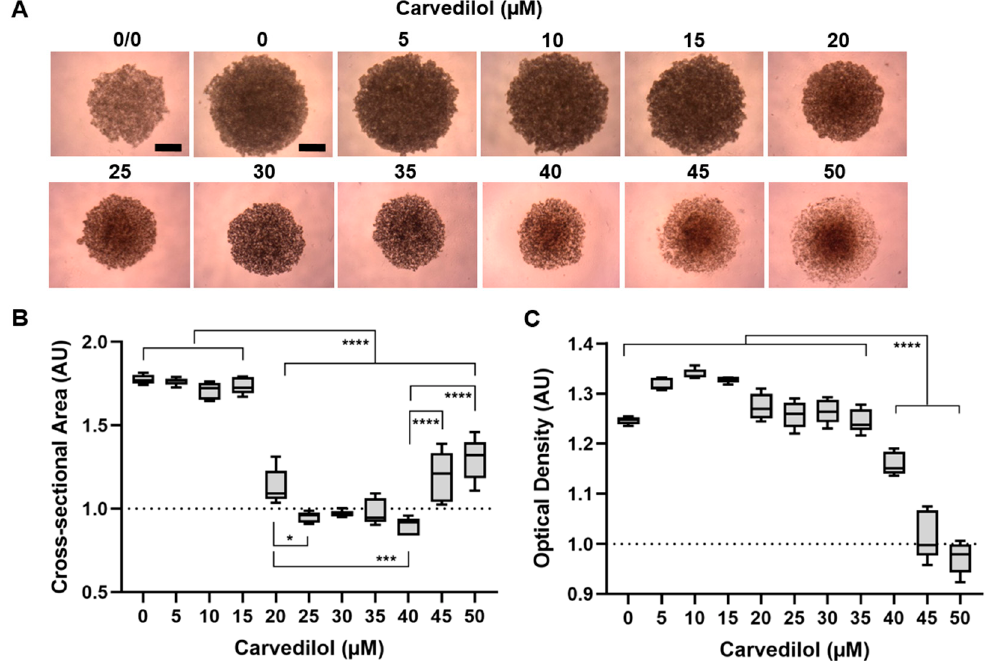
Figure 3. Effects of carvedilol on 3D tumor spheroid growth and compactness. Mel270 spheroids were treated with carvedilol at the indicated concentrations for 7 days. The spheroids were microscopically imaged and size and density were measured. ( A ) Representative microscopic images of the spheroids are shown. Untreated spheroids just before treatment (0/0), and spheroids after 7 days of incubation with 0–50 µM carvedilol (4× magnification): scale bars indicate 500 µm. ( B , C ) Spheroid cross-sectional area and optical density were determined and normalized to spheroids before treatment (0/0). Box plots with min to max whiskers and a median of n = 5 spheroids for each condition are shown. The mean of the cross-sectional area or the optical density of the spheroids before treatment (0/0) are indicated by dotted lines. Representative results from 3 independent experiments are shown. Statistical analysis by one-way ANOVA and Tukey’s multiple comparisons test, significance levels are indicated at * p < 0.05, *** p < 0.001, and **** p < 0.0001.